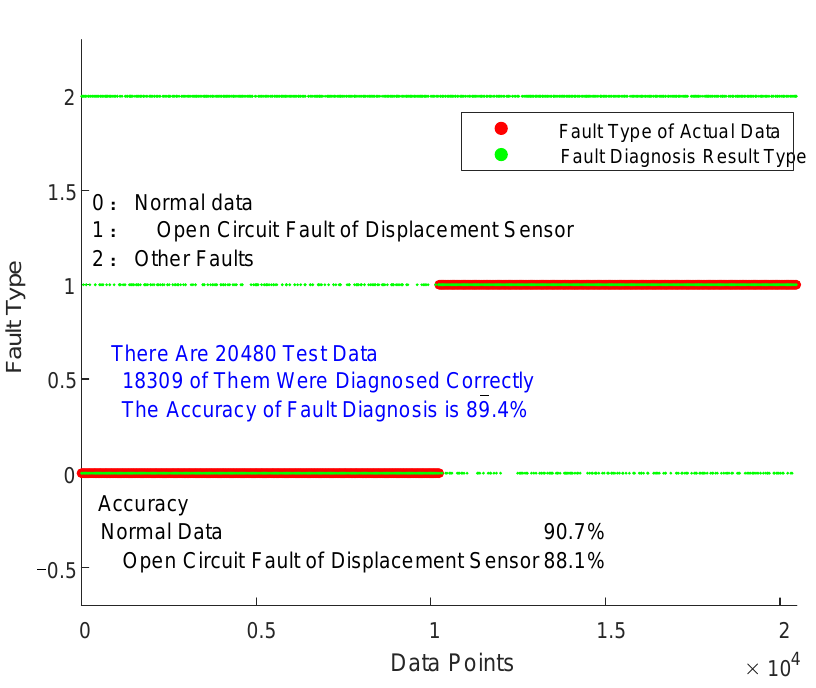
Figure 19. Experimental results obtained on the actual EMA.